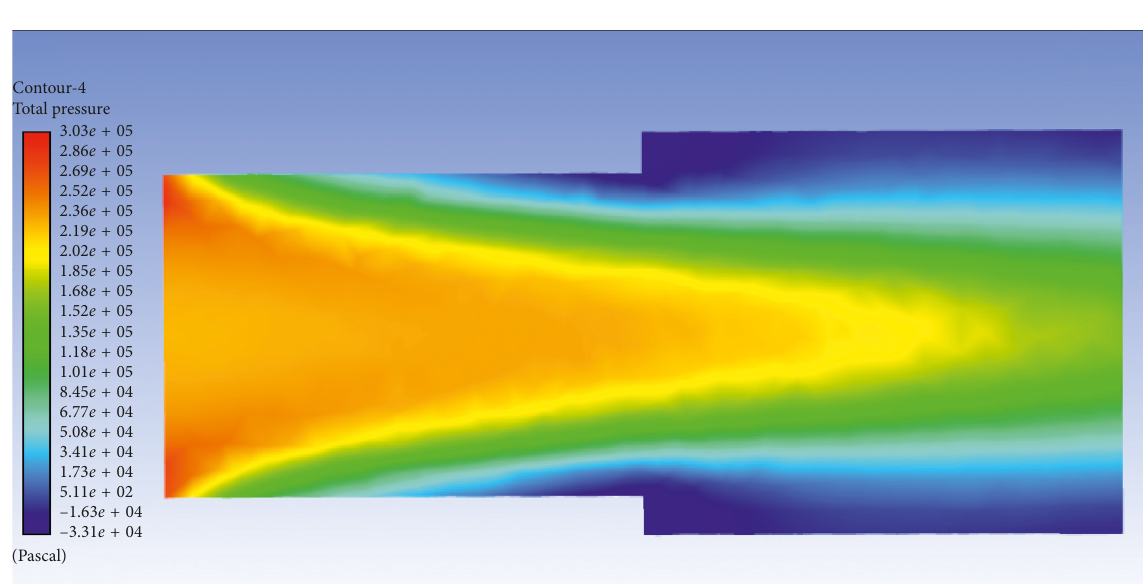
Figure 12: Pressure nephogram (sudden expansion ratio is